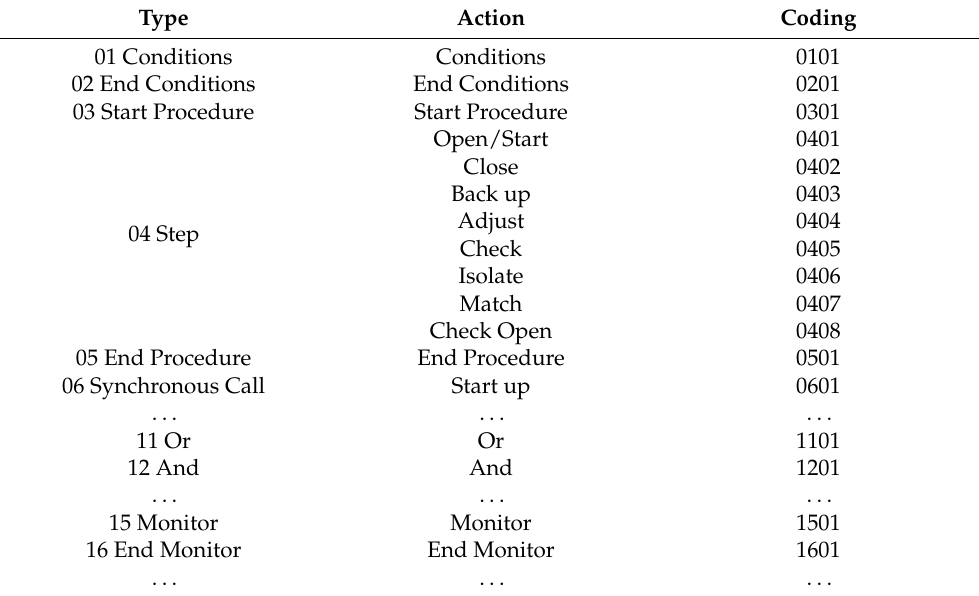
Table 3. Examples of action